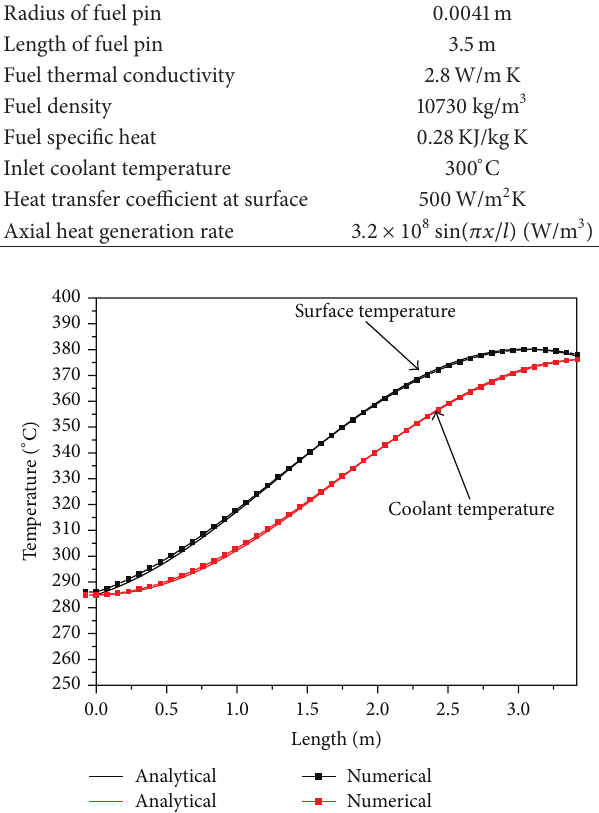
Figure 5: Benchmarking ofcoolant and surfacetemperature predic- tion.